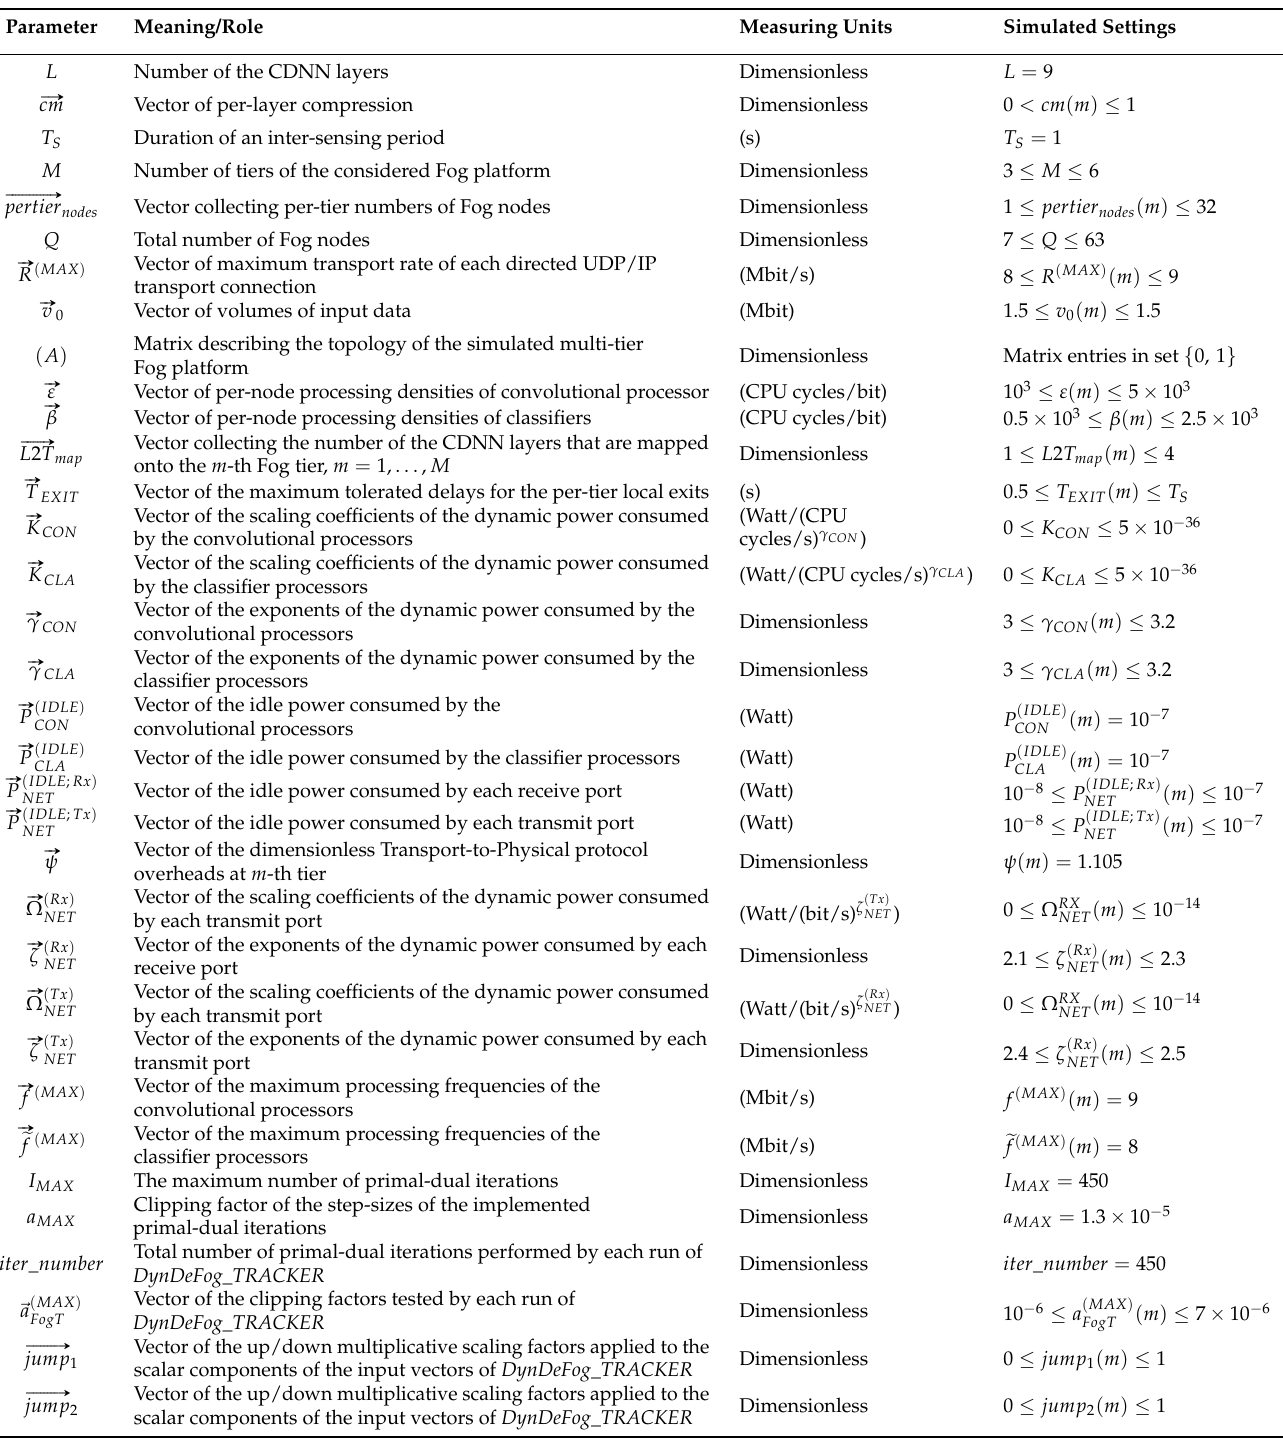
Table A2. Input parameters of the DeepFogSim simulator and their simulated settings of Section